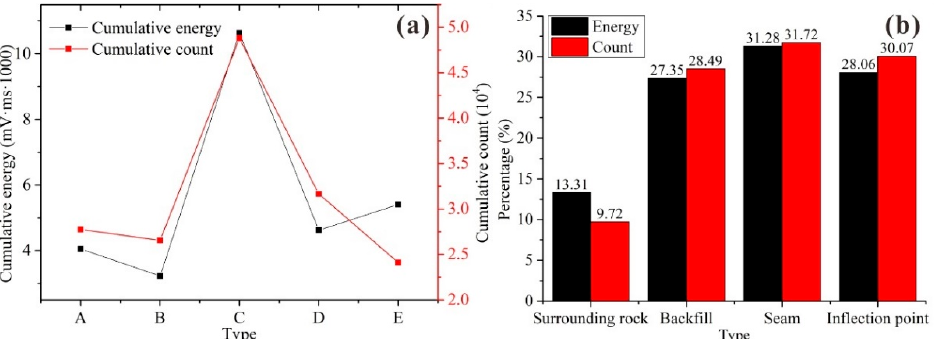
Figure 15. Acoustic emission data statistics. ( a ) Energy and cumulative energy curves; ( b ) energy and count statistics.